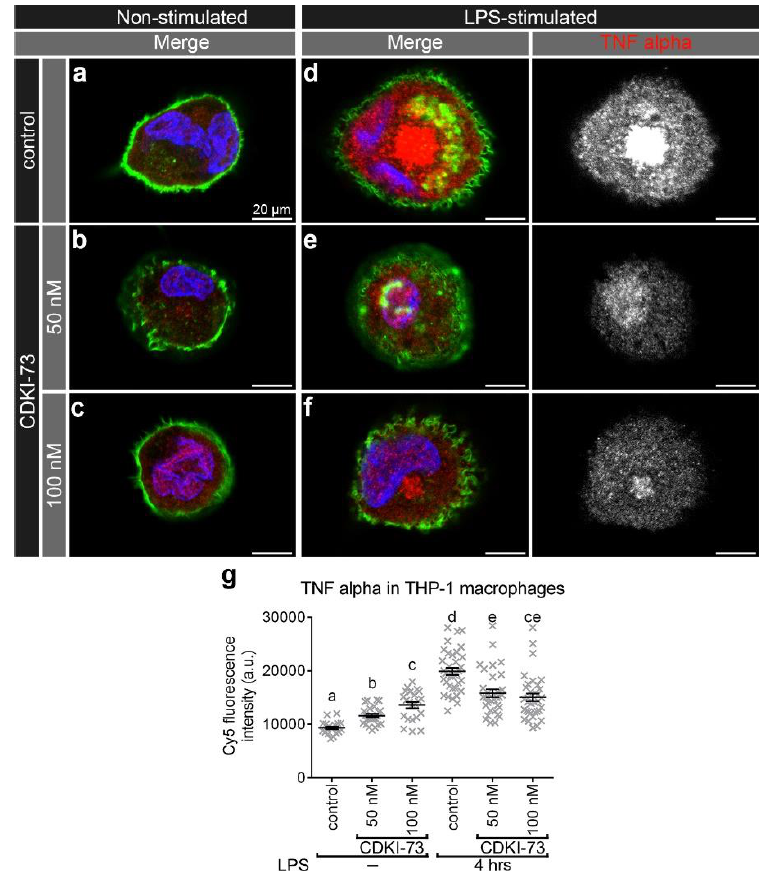
Figure 6. CDKI-73 depletes tumour necrosis factor alpha (TNF α ) in LPS-stimulated THP-1 macrophages. ( a – f ) Confocal micrographs showing TNF α detected with anti-TNF α antibody (red) in relation to the plasma membrane outlined with Alexa Fluor ® 488 Phalloidin (green). The nucleus was depicted by staining with Hoechst 33,258 DNA stain (blue). Representative images were from control THP-1 macrophages ( a , d ), and THP-1 macrophages treated either with CDKI-73 at 50 nM ( b , e ) or 100 nM ( c , f ) for four hours. The visualised macrophages were non-stimulated ( a – c ) and LPS-stimulated for six hours ( d – f ). Scale bars: 20 µ m. ( g ) Histogram showing comparative analysis of TNF α -Cy5 signal in the designated samples. One-way ANOVA and Tukey’s multiple comparison test showed significant di ff erences between the means in designated groups (depicted by di ff erent letters on the bars, p < 0.0001). Data are represented as mean ± SEM.